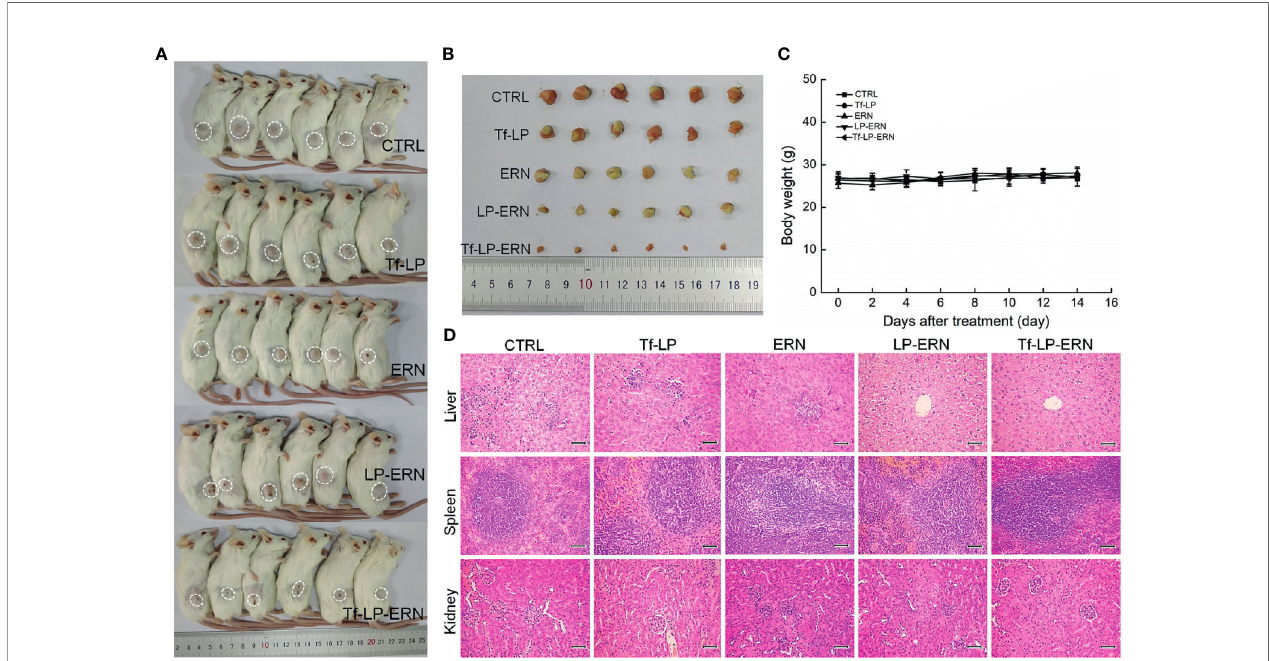
FIGURE 5 | ERN, LP-ERN and Tf-LP-ERN suppressed the tumor growth and showed biological safety in SMMC-7721-xenotransplanted BALB/c mice. The tumor volume comparison in (A) SMMC-7721-xenotransplanted BALB/c mice, and (B) their collected tumors (n = 6). Tf-LP, ERN, LP-ERN and Tf-LP-ERN showed no signi fi cant effects (C) on the body weight and (D) histopathologic changes including liver, spleen and kidney in SMMC-7721-xenotransplanted mice (magni fi cation: 200, scale bar: 50 m